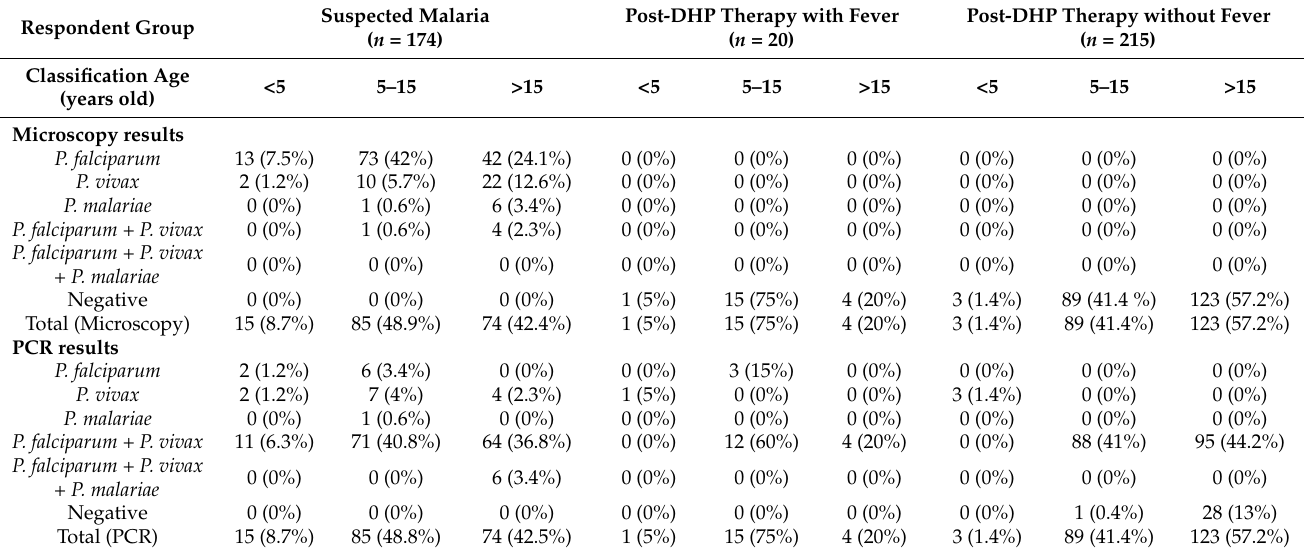
Table 2. Plasmodium species identification results through microscopic and nested PCR of partici- pants with suspected malaria, post-DHP therapy with fever and without fever.